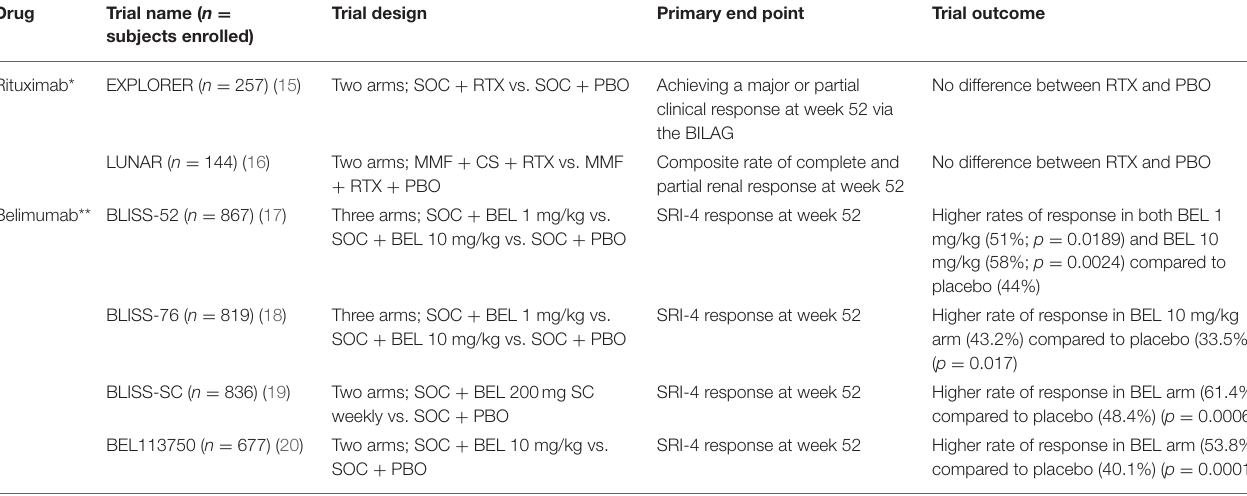
TABLE 2 | Landmark trials.